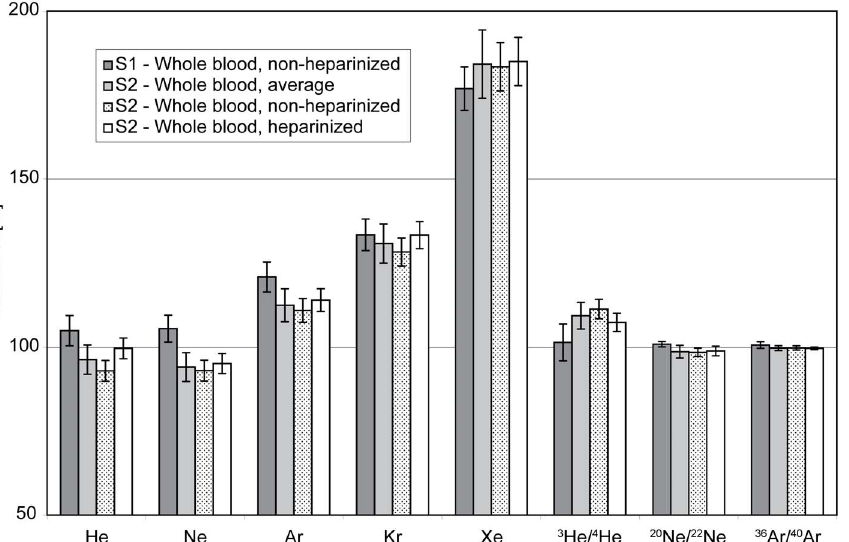
Figure 2. Percentage saturation of whole human blood from subjects S1 and S2 with various noble gases and noble-gas isotope ratios under different environmental conditions (see Table 3 for details). The agreement between the measurements conducted on the two subjects demonstrates that the methods yield reproducible results.